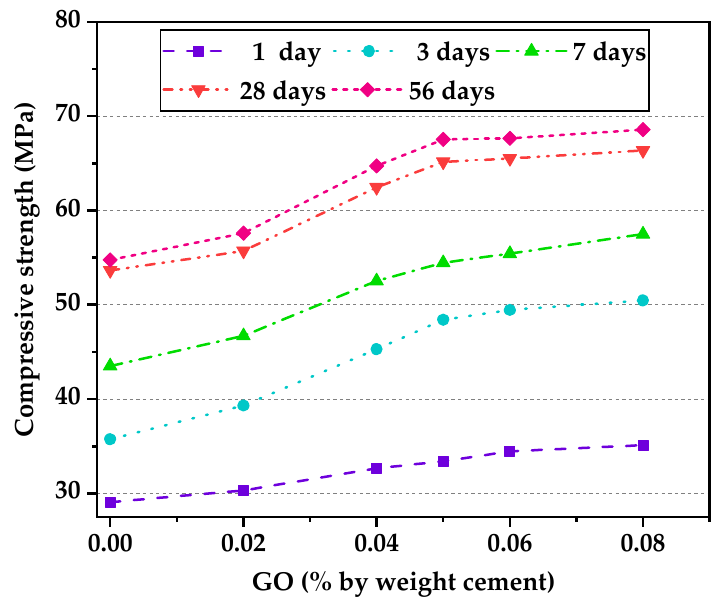
Figure 3. Compressive strength of concrete with varying GO content.